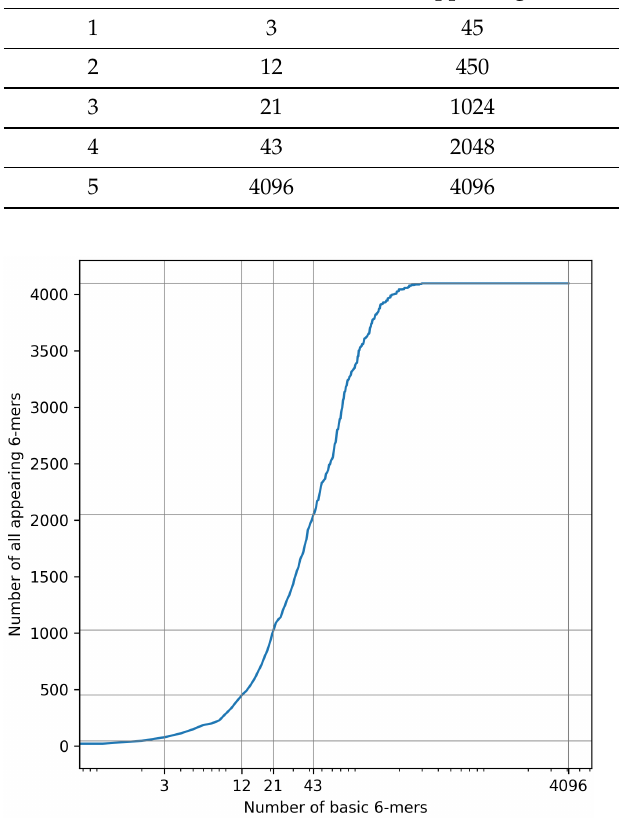
Figure 4. Number of all 6-mers appearing, depending on number of basic